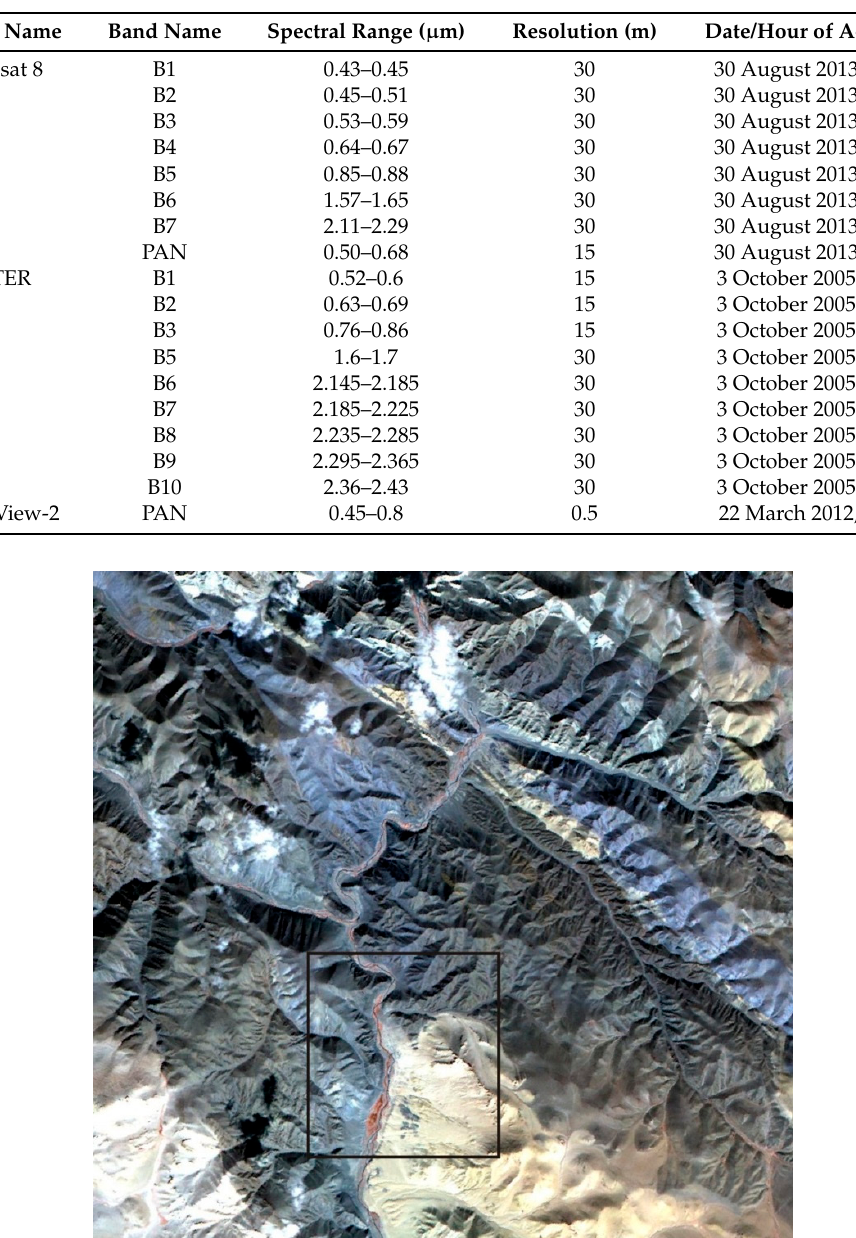
Table 1. Technical specifications of image datasets used in the study.